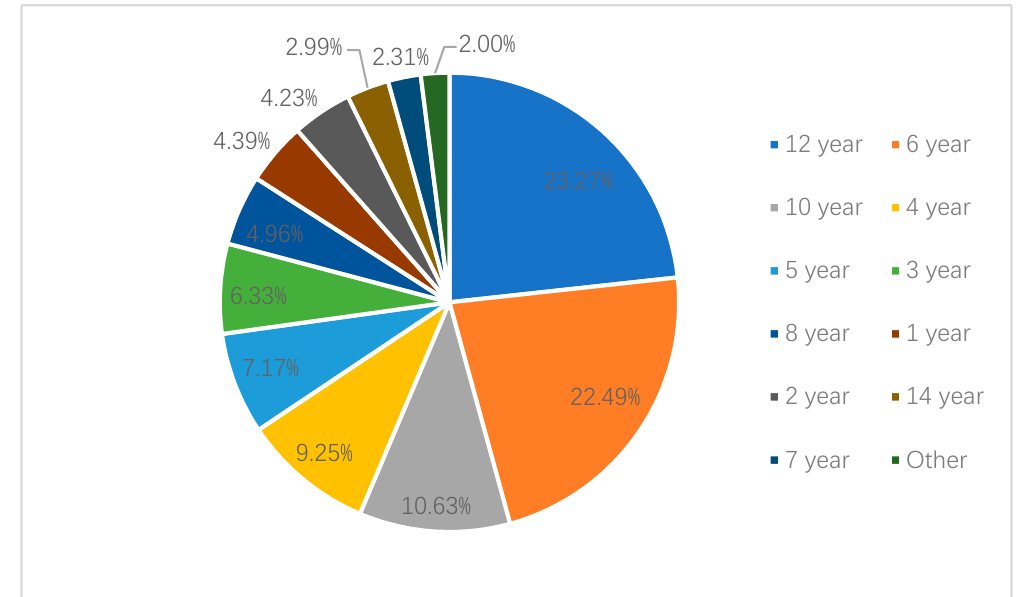
Figure 2. Recognized height criteria of national child restraint legislation by parents in Shanghai.